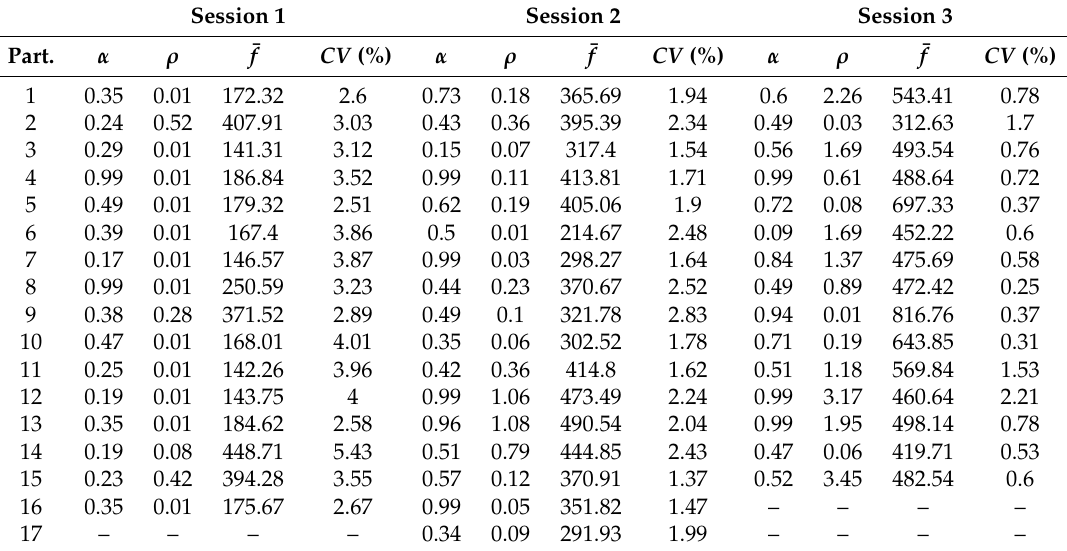
Table 12. Fitted parameters for quadratic H model ( ESH 2) for the three sessions.